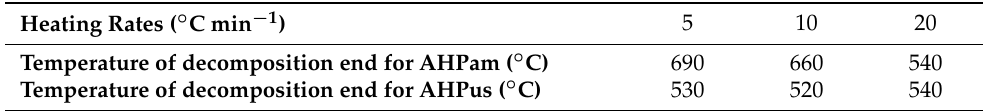
Table 5. End decomposition temperature of AHPam and AHPus, measured during TGA combustions under air